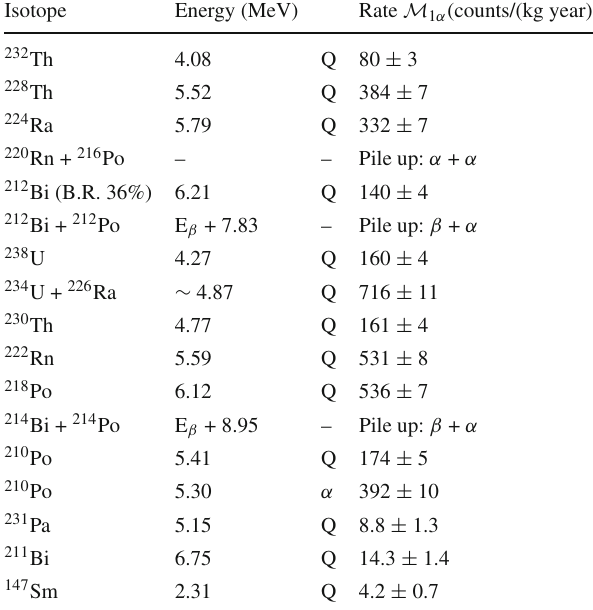
Table 3 Counting rate of α -peaks due to 238 U, 235 U and 232 Th decay chains. All the isotopes appear only as Q-value peak (Q), except 210 Po that shows also the α -peak. Since the line shape is not perfectly Gaus- sian and some peaks are partially overlapped, the activity evaluation is affected by a systematic error up to 10%, depending on the method used to evaluate the net number of counts in the α peaks. A few lines are depleted by pile-up effects, or summed to β coincident events, therefore their activities cannot be directly evaluated